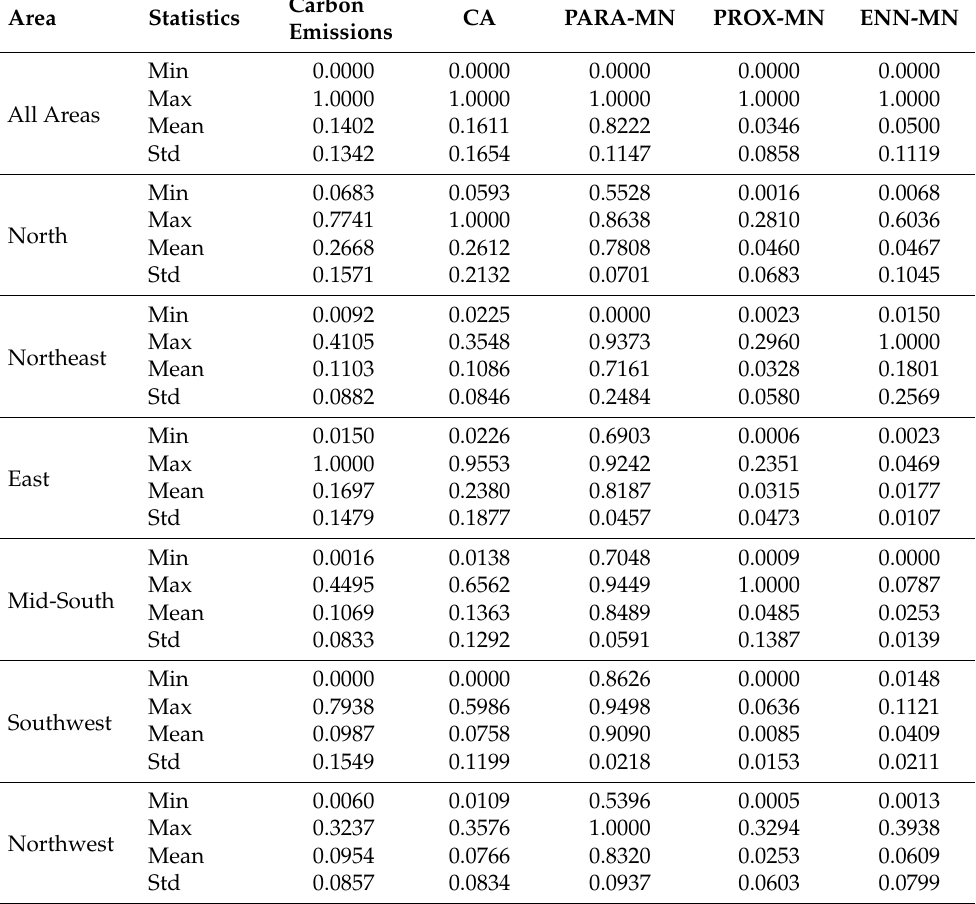
Table 3. The characteristics of each region are as follows. Table 3. Result statistics of urban form